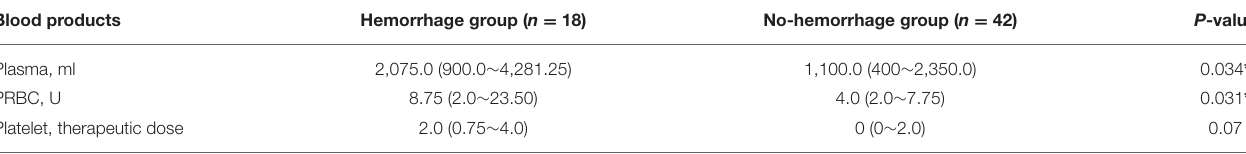
TABLE 8 | Blood transfusions in the whole course of treatment.